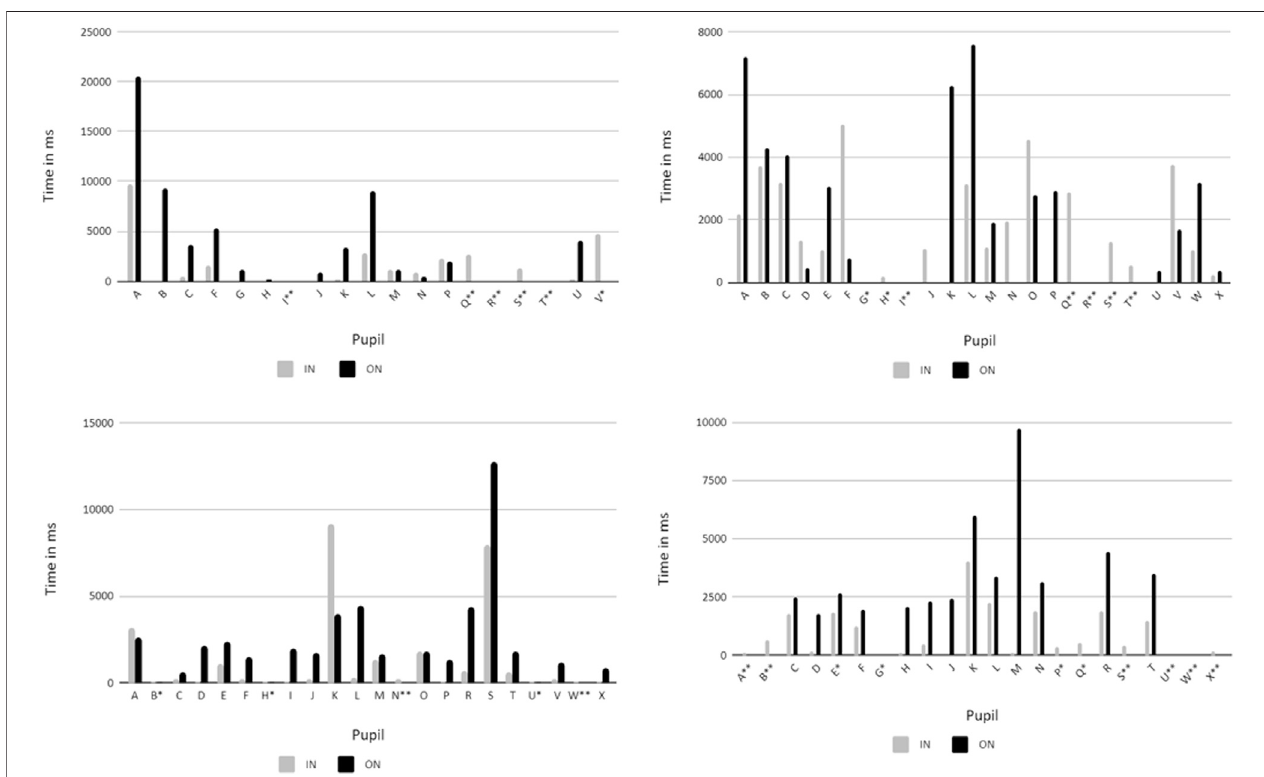
FIGURE 6 | Dwell times for individual pupils in IN and ON condition T2 (from left to right — T2_1, T2_2, T2_3, T2_4). Two stars — pupil invisible in ON condition; one star — pupil poorly or rarely visible or almost invisible in ON